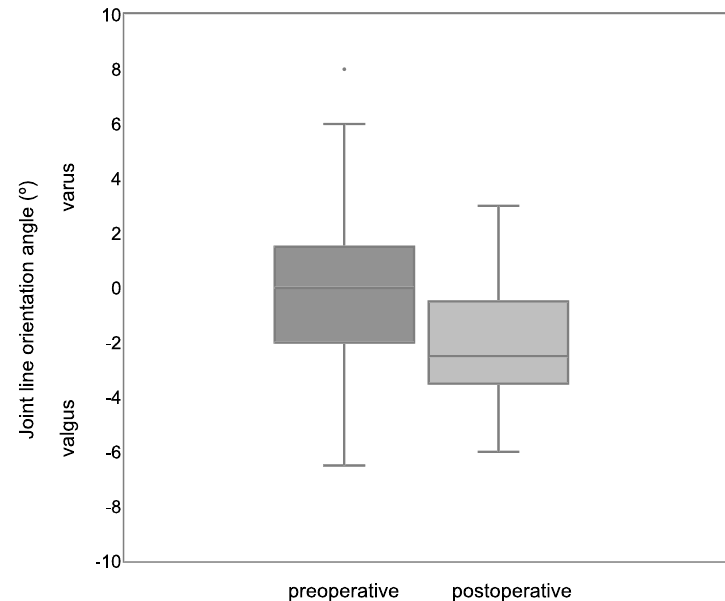
Fig. 6 Preoperative and postoperative JLOA. Sixty-nine percent of the postoperative JLOA are within postoperative JLOA were in valgus orientation. Abbreviations: JLOA: joint line orientation